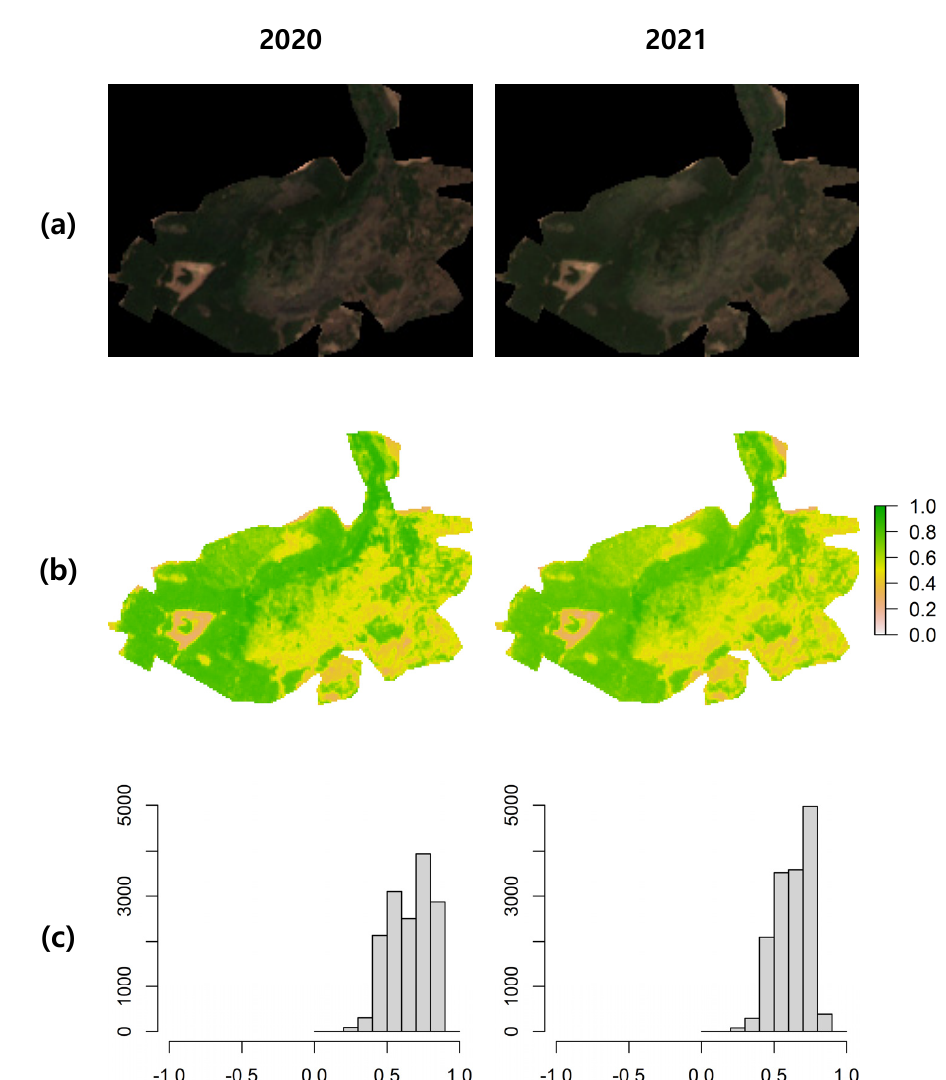
Figure 4. RGB and NDVI image of Geomunoreum forest from 2020 to 2021. ( a ) RGB image; ( b ) NDVI image; ( c ) histogram of NDVI frequency distribution.